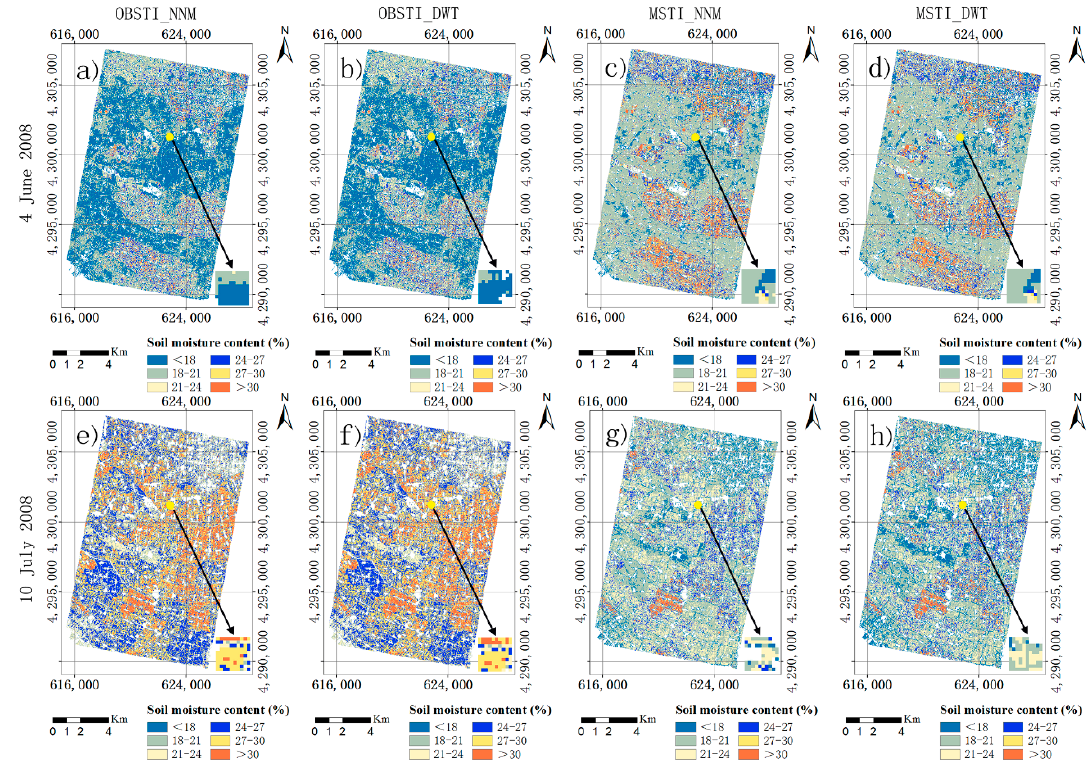
Figure 14. Comparison of spatial distributions of predicted soil moisture contents derived using ( a ) and ( e ) the original-model-derived bare STI at the 15 m resampling spatial resolution (OBSTI_NNM); (b ) and ( f ) the modified-model-derived STI at the 15 m resampling spatial resolution (MSTI_NNM); ( c ) and ( g ) the original-model-derived bare STI at the 15 m fusion spatial resolution (OBSTI_DWT); and, ( d ) and ( h ) the modified-model-derived STI at the 15 m fusion spatial resolution (MSTI_DWT) on June 4 th and July 10 th 2008, respectively..